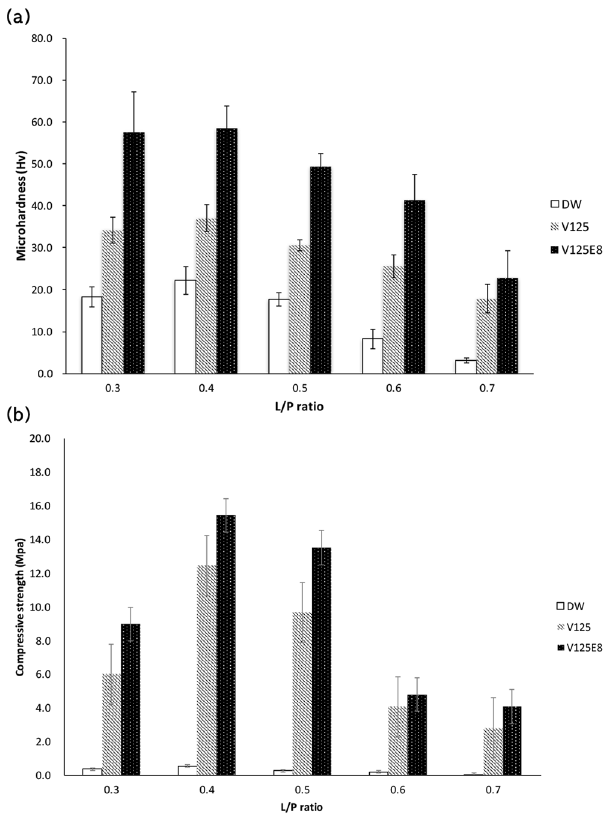
Figure 1. Microhardness ( a ) and compressive strength ( b ) of CPC composites. V125-E8 had the highest values at all L/P ratios; DW had the lowest. V125-E8 had a microhardness 2- to 7-fold higher and a compressive strength > 10-fold higher than DW. The microhardness and compressive strength tended to decrease as the L/P ratio increased. However, the highest microhardness and compressive strength were observed at an L/P ratio of